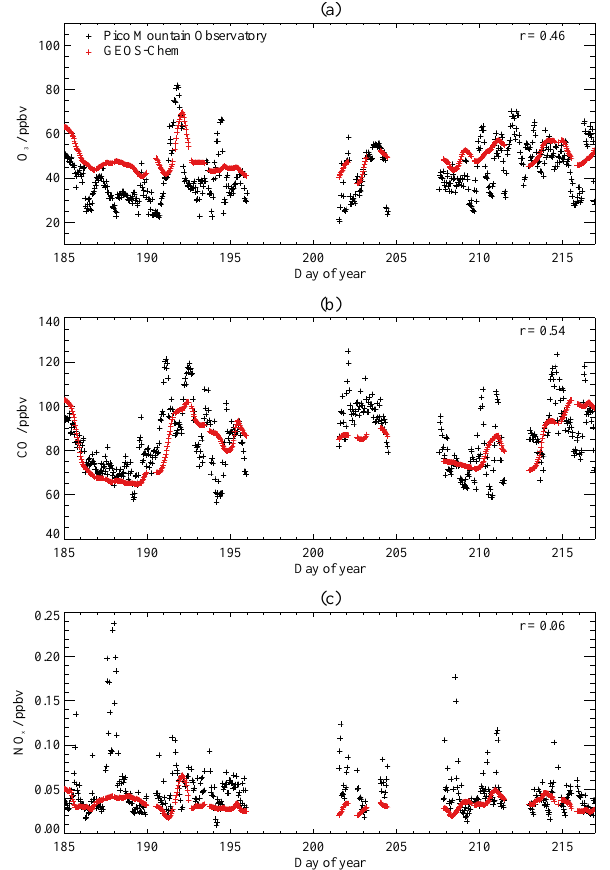
Fig. 5. Time series of (a) ozone, (b) CO, and (c) NO x measured at the Pico Mountain Observatory (black symbols), and the co-located model output (red symbols), from 4 July to 4 August 2010 inclusive. The correlation coefficient, r , between the observed and model time series is given in each